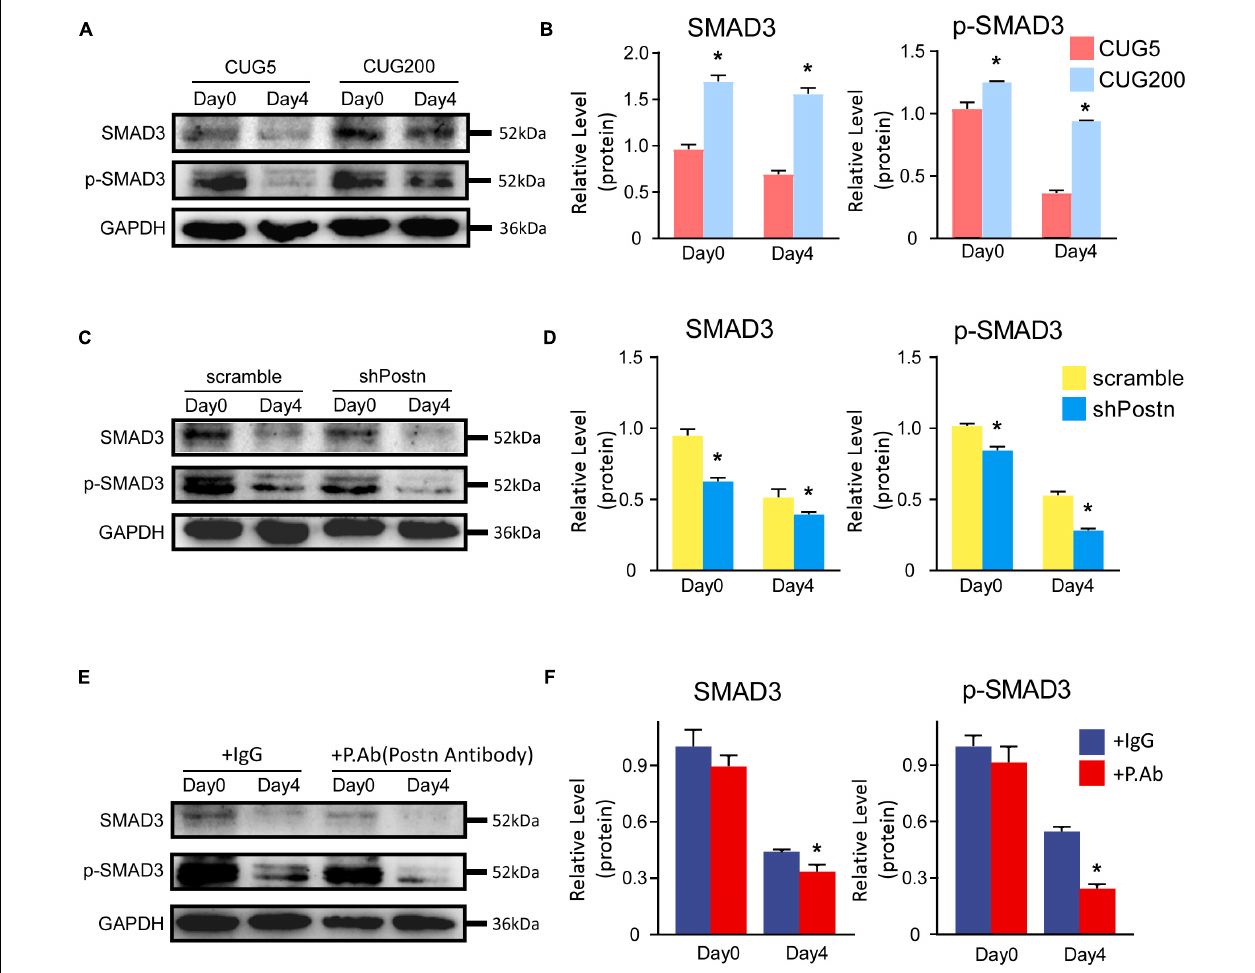
FIGURE 8 | Postn regulated myogenesis likely through TGF-b/Smad3 pathway in DM1 myoblasts. (A) The levels of SMAD3 and p-SMAD3 in normal and DM1 myoblasts at differentiation day 0 and day 4 were determined by western blots. (B) Gel band intensities from (A) quantified with ImageJ software. GAPDH served as an internal control. All expression levels were normalized to the normal myoblasts at day 0. (C) The levels of SMAD3 and p-SMAD3 in scramble control and Postn knockdown DM1 myoblasts at differentiation day 0 and day 4 were determined by western blots. (D) Gel band intensities from (C) quantified with ImageJ software. (E) The levels of SMAD3 and p-SMAD3 in the control IgG antibody and POSTN neutralizing antibody treated DM1 myoblasts at differentiation day 0 and day 4 were determined by western blots. (F) Gel band intensities from (E) quantified with ImageJ software. GAPDH served as an internal control. All expression levels were normalized to the scramble control DM1 myoblasts at day 0. CUG5, normal control myoblast cells (C2C12 GFP-CUG5); CUG200, DM1 myoblast cells (C2C12 GFP-CUG200); scramble, scrambled control DM1 myoblast cells; shPostn, Postn knockdown DM1 myoblast cells; IgG, control IgG antibody; P.Ab, POSTN neutralizing antibody; * P <